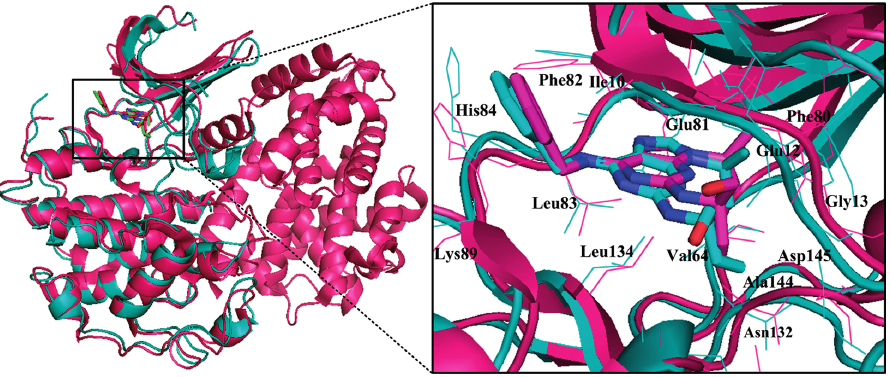
Figure 12. Comparison of the structures of the free and phosphorylated CDK2 dimer in complex with roscovitine. The cyan and fuchsia patterns indicate the monomeric CDK2 (coordinates 2A4L) and the phosphorylated CDK2/cyclin A dimer (3DDQ) in a complex with roscovitine, respectively.